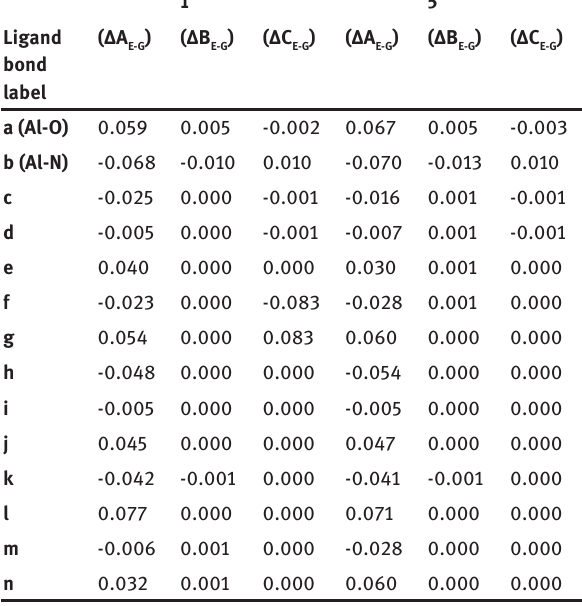
Table 3: The differences of the bond lengths (A o ) between the first excited state (CIS/6-31G(D) and the ground state [HF/6-31G(D)] for ligands A (∆A ), B (∆B ) and C(∆C ) respectively for 1 and 5 (for E-G E-G E-G ligand bond labels see Fig.